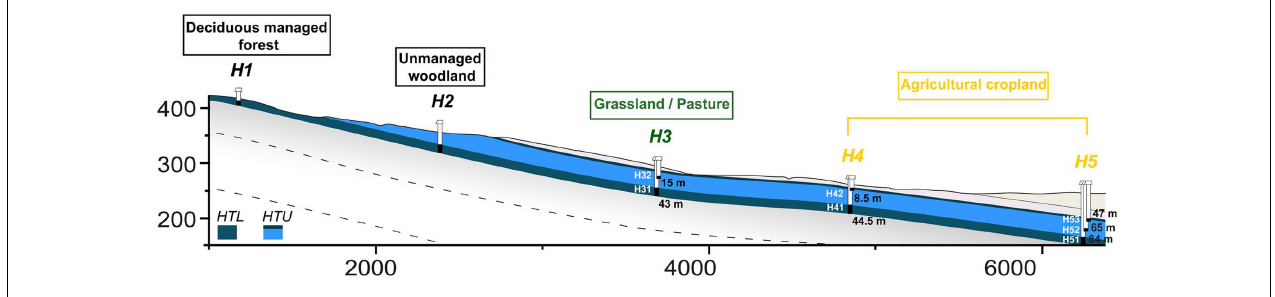
FIGURE 1 | Graphical illustration of groundwater wells in the Hainich Critical Zone Exploratory (Hainich CZE) at site H3 (located in grassland/pasture), H4 and H5 (located in agriculture/cropland) with their distances from the surface. The illustration is 4X vertically exaggerated. Groundwater samples were collected and analyzed from the sampling sites; H31, H41, and H51 (in Hainich transect lower – HTL aquifer assemblage) and H32, H43, H52, and H53 (in Hainich transect upper – HTU aquifers assemblage). Adapted base figure from Küsel et al. (2016).